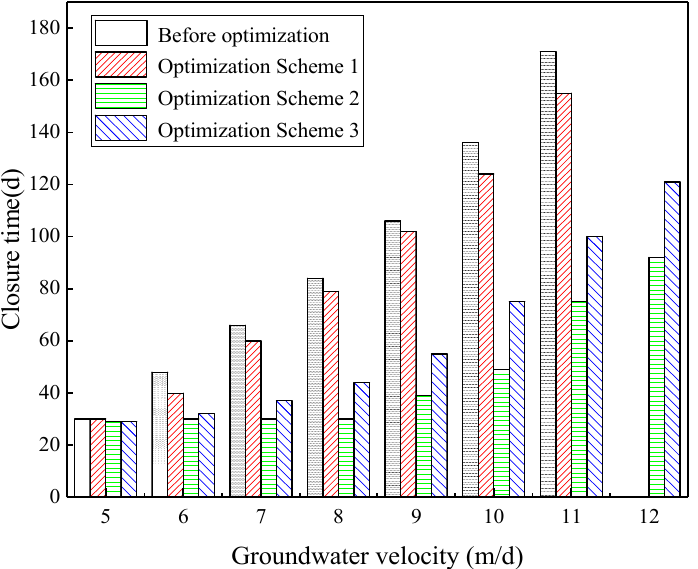
Figure 12. Comparative analysis of closure time of frozen walls formed by different optimization schemes. In the optimization scheme 3, the distance between the auxiliary freezing hole and the freezing hole layout circle was the key factor affecting the closure time of the frozen wall. The influence of this factor on the closure time of frozen walls is shown in Figure 13. It can be seen from Figure 13 that the optimal setting distance of the auxiliary freezing pipe is 2 m when the groundwater velocity is 5 m/d~7 m/d and the optimal setting distance of the auxiliary freezing pipe is 2.5 m when the groundwater velocity is greater than or equal to 8